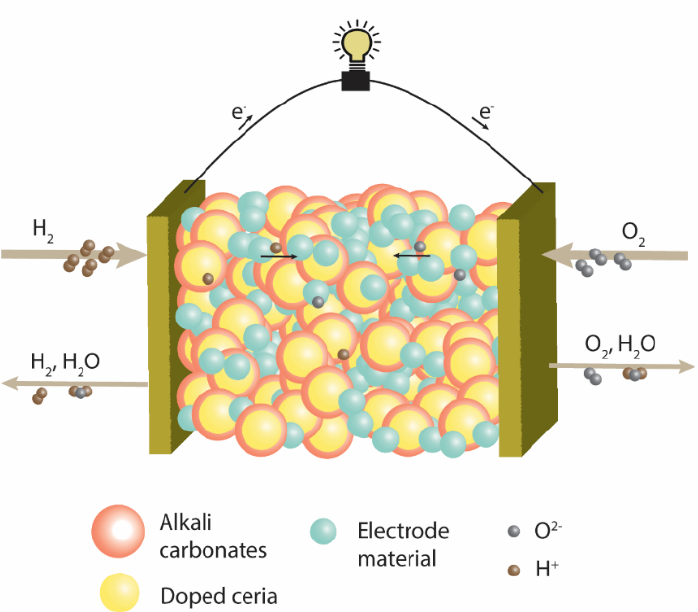
Figure 1. Schematic of working principle of a single-layer ceramic fuel cell. Various materials have been reported in single-layer ceramic fuel cells. Ionic con- ductors used in single-layer cells are mostly based on pure doped ceria, and compos- ites of doped ceria and alkali carbonates. The electrode materials used in single-layer cells include LiCoO 2 -LiFeO 2 [10], Ni 0.8 Co 0.15 Al 0.05 LiO 2 [11], La 0.6 Sr 0.4 Co 0.2 Fe 0.8 O 3- δ [12], CuFe 2 O 4 [13,14], Li 0.15 Ni 0.25 Cu 0.1 Zn 0.2 Fe 0.3 O x [15], Li 0.3 Ni 0.6 Cu 0.07 Sr 0.03 O 2- δ [16], Sr 2 Fe 1.5 Mo 0.5 O 6- δ [17], Li 0.15 Ni 0.45 Zn 0.4 O 2 [18], etc. In addition, proton conductors (BaCe 0.7 Zr 0.1 Y 0.2 O 3- δ ) have been used in single-layer cells [19]. Although single-layer cells have been reported as having high performance, we observed that the studies mostly utilized Ni 0.8 Co 0.15 Al 0.05 LiO 2 (NCAL)-coated Ni foams as the “current collector”. In our previous study [9], we showed that NCAL-coated Ni foams acted as electrodes when applied on the sides of the cells, making them similar to a conventional three-layer cell structure. Removing NCAL-coated Ni foam reduced the performance of single-layer cells by more than half [9].